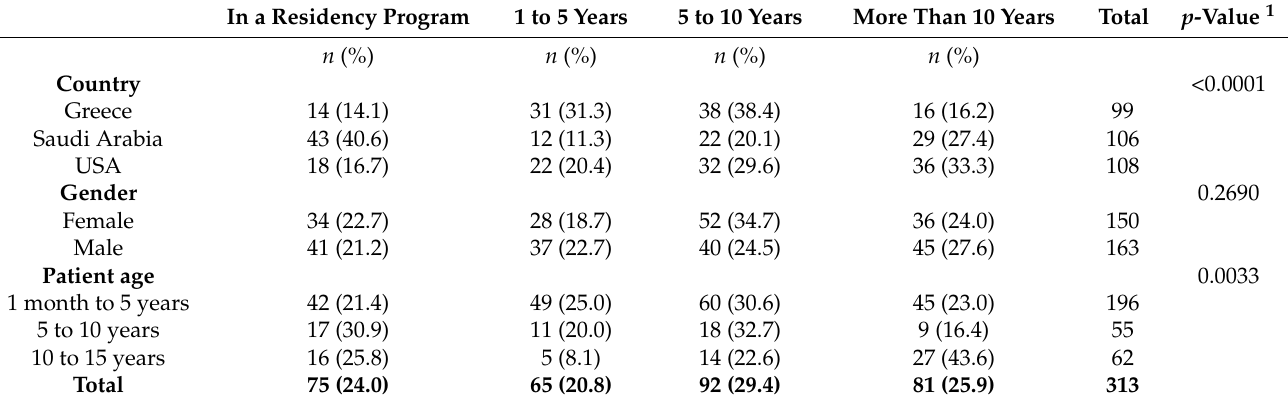
Table 1. Experience in dentistry according to country, gender, and patient age.